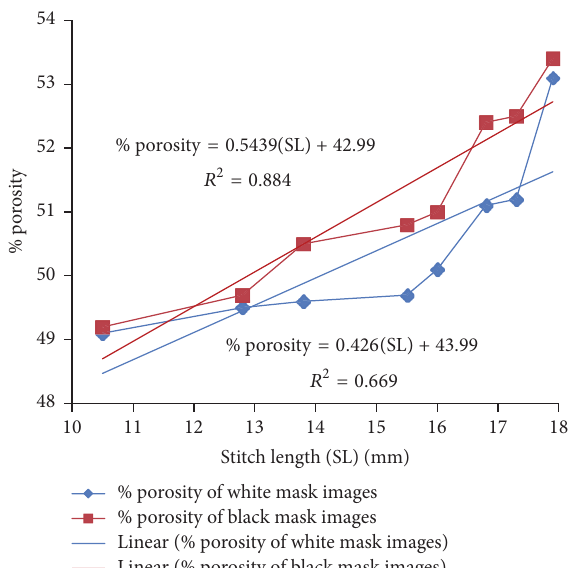
Figure 6: Percentage porosity against stitch length (SL) for rib 1×1 structure for